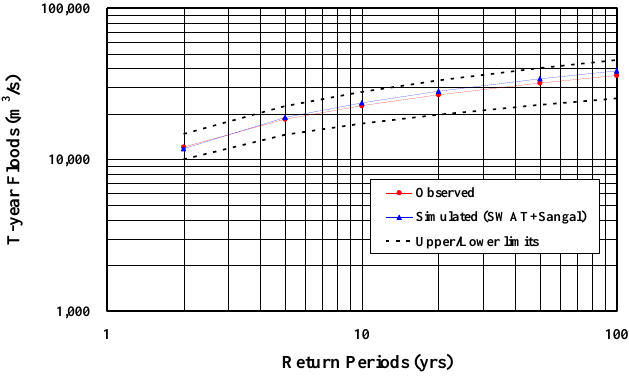
Figure 14. Annual Maximum Series according to the Scenarios (Hourly).